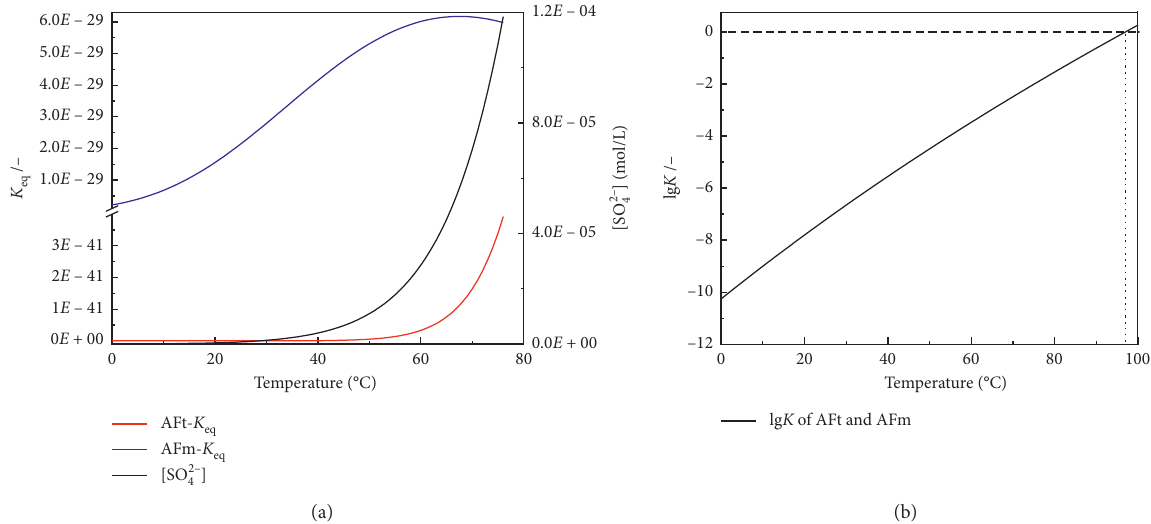
Figure 4: Curves of thermodynamic equilibrium constant and critical concentration of sulfate ion versus temperature. (a) Thermodynamic equilibrium constant and sulfate ion concentration. (b) Thermostability of the AFt and